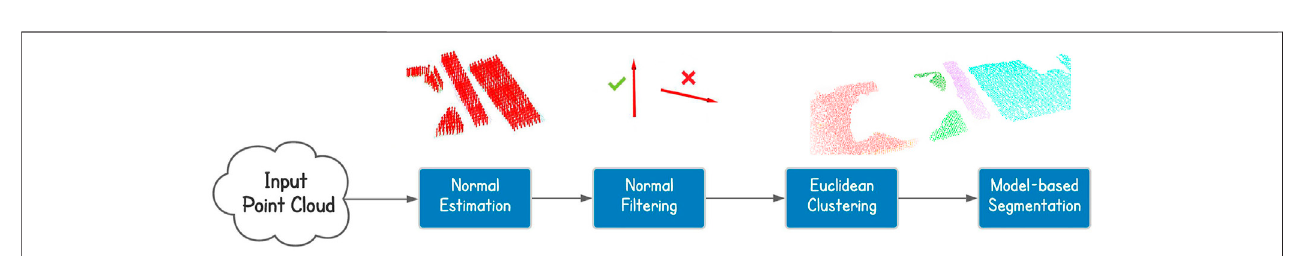
FIGURE 3 | Cloud processing for horizontal plane segmentation. From the point cloud we perform normal estimation, normal fi ltering based on the orientation, euclidean clustering and model-based segmentation.